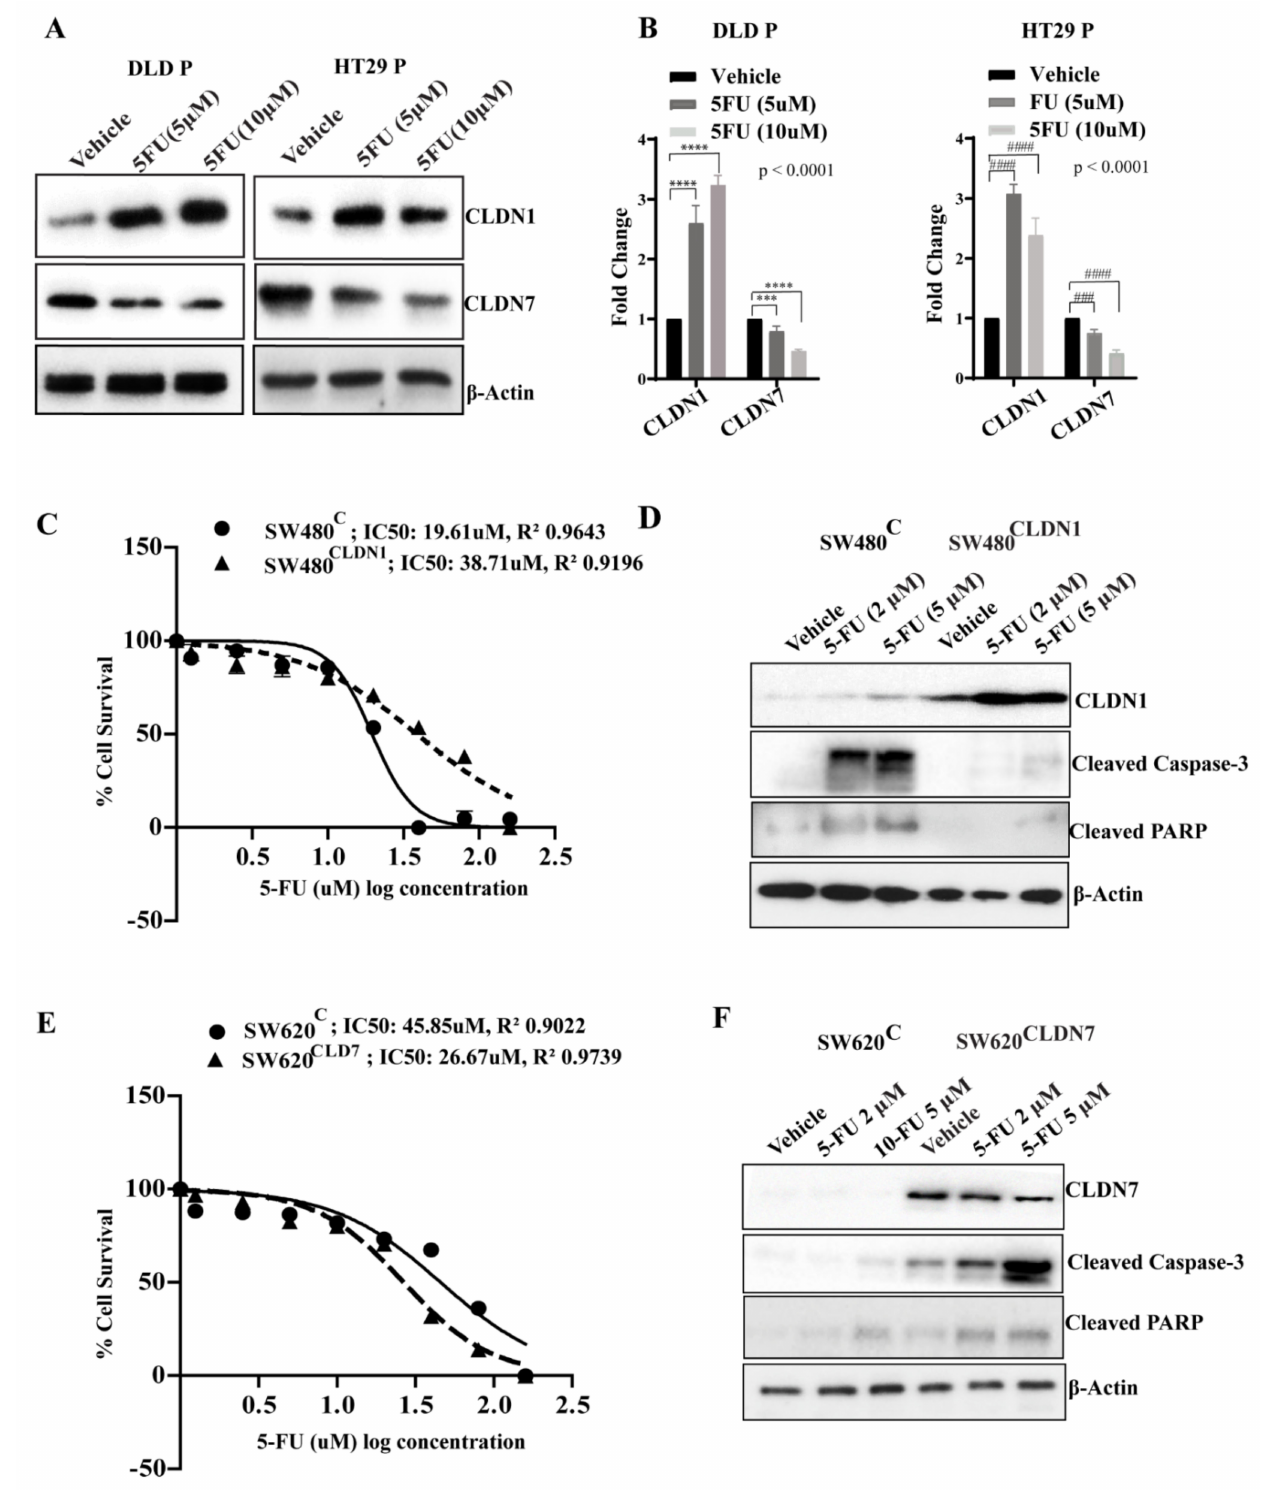
Figure 3. CLDN1 and CLDN7 expression in 5-FU treatment and resistance. ( A , B ) Western blot analysis of CLDN1 and CLDN7 in DLD and HT29 cells subjected to 5-FU treatments (5 and 10 µ M) and corresponding densitometric analysis of protein levels quantified using ImageJ. β -Actin served as an internal control. The y-axis represents fold change compared to untreated parental (DLD/HT29) cells. Error bars represent the mean ± SD of three independent experiments ( n = 3). Statistical analysis was conducted using one-way ANOVA with significance represented using the following symbols: ***/ ### p ≤ 0.001,****/ #### p ≤ 0.0001; ( C ) SW480 Con and SW480 CLDN1 cells were treated with a range of 5-FU doses (160 µ M to 0.0125 µ M); IC50 values were determined using cell viability assay, and the values were fit into a sigmoidal